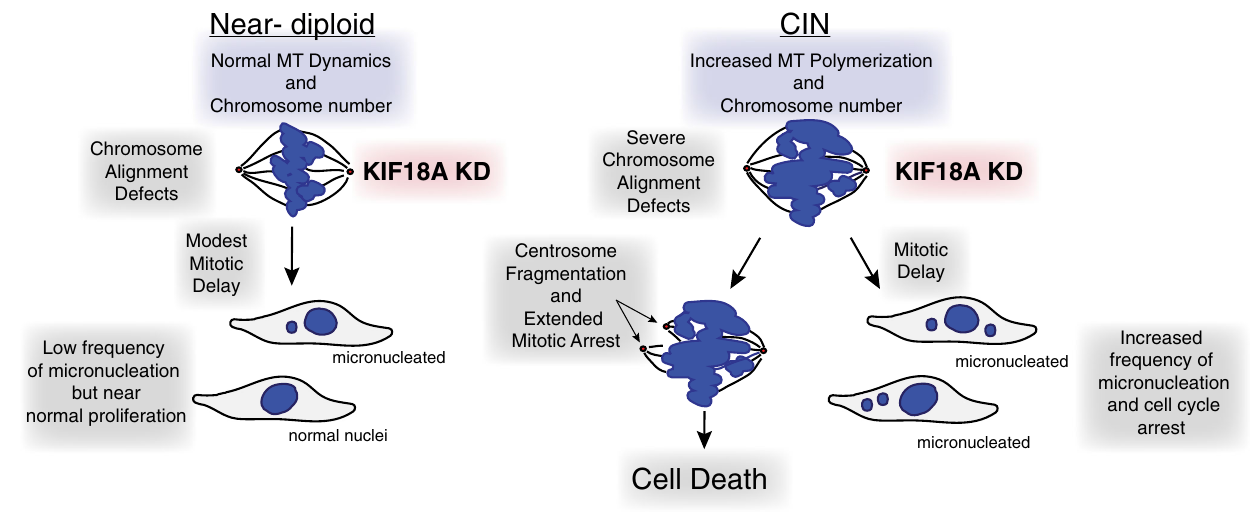
Fig. 9 Model for selective dependence of CIN cells on KIF18A function. Schematic summarizing the differential responses of CIN and near-diploid cells to KIF18A knockdown (KD). Increased microtubule polymerization rates in CIN cells may sensitize them to further deregulation of microtubule dynamics caused by loss of KIF18A function, leading to force imbalances that disrupt the integrity of the spindle. See “ Discussion ” for additional